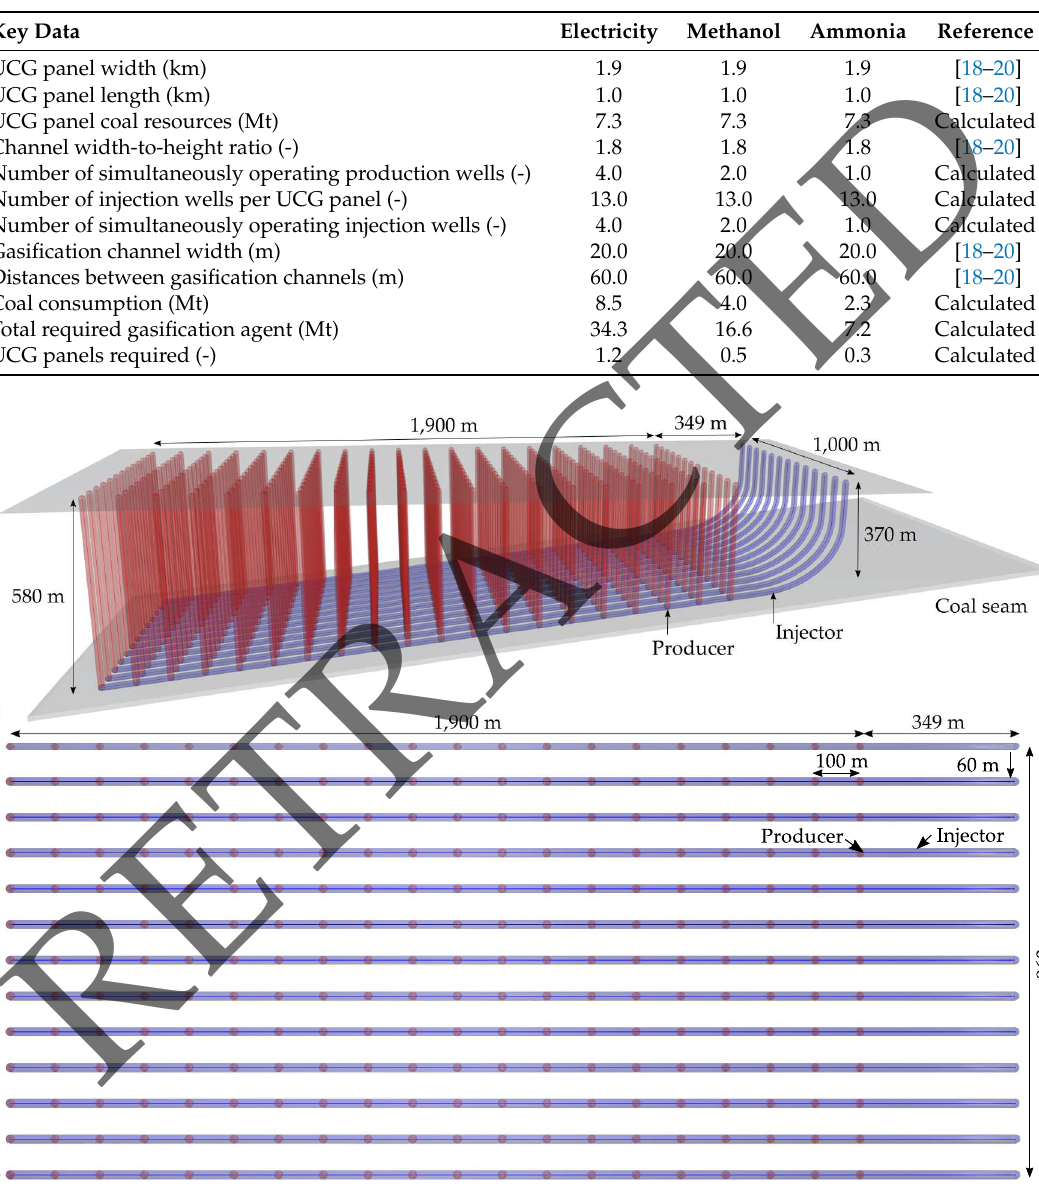
Figure 4. Computer-Aided Design (CAD) model visualizing ( a ) 3D perspective and ( b ) plan view of the onshore well design for one UCG panel with 13 reactor channels and 260 production wells, utilised as basis for drilling cost